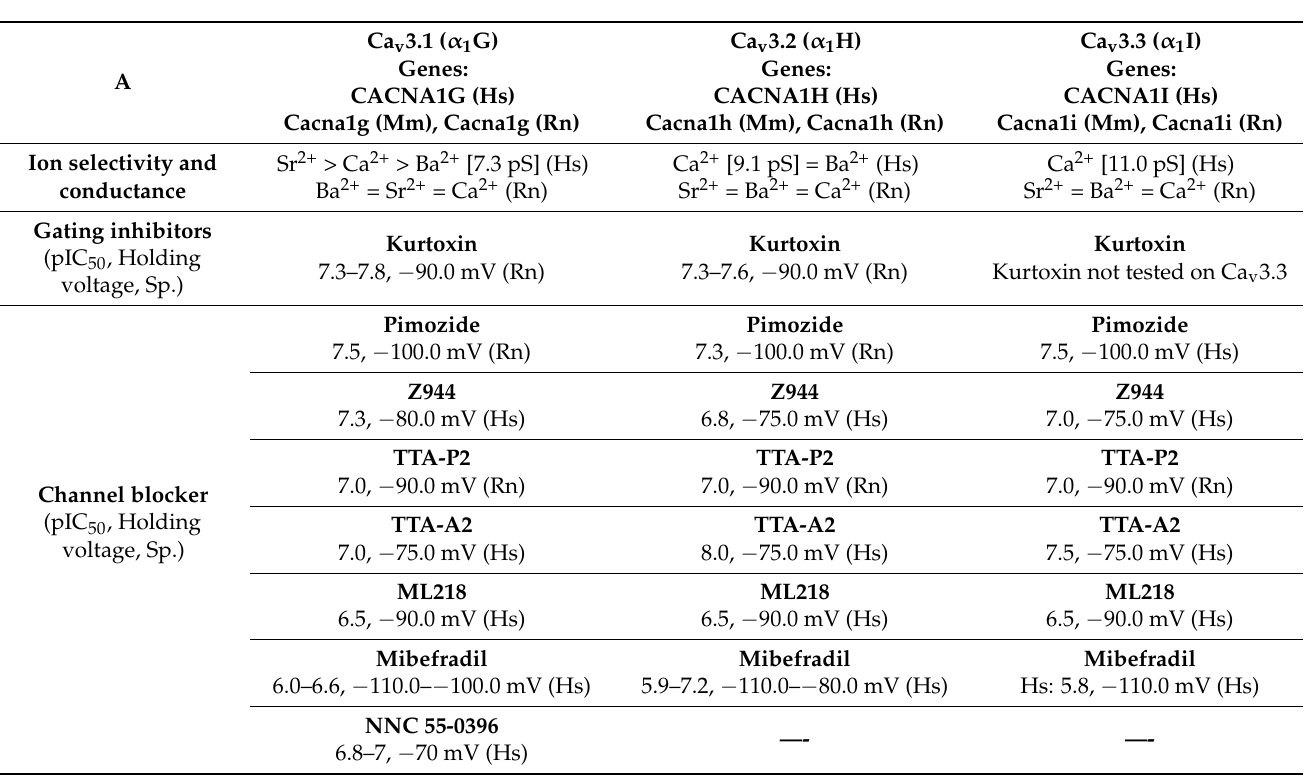
Table 1. Biophysical, electrophysiological, and pharmacological characterization of LVA Ca v 3.1–3.3 T-type VGCCs. Ten different pore-forming Ca v α 1 -subunits have been cloned so far that are dif- ferentiated into three subfamilies, i.e., the HVA, dihydropyridine (DHP)-sensitive, L-type Ca v 1.x channels, the HVA, DHP-insensitive Non-L-type Ca v 2.x channels, and the LVA T-type Ca v 3.x chan- nels. Note that some HVA channels, such as Ca v 1.3 and Ca v 2.3, were also reported to exhibit moderate/mid-voltage activation thresholds and LVA characteristics under specific experimental and (patho)physiological settings. Each pore-forming α 1 -subunit is composed of four homologous domains (repeats I–IV), each of which contains six α -helical transmembrane segments (S1–S6). The pore-forming area is built up by the region between S5 and S6 of the four domains. Voltage-dependent gating of VGCCs is mediated by the voltage sensor, which is localized in the membrane spanning S4 segments and acts via highly conserved positive charges, predominantly arginine residues. Im- portantly, all Ca v α 1 -subunit transcripts are subject to alternative splicing, which can significantly affect biochemical and electrophysiological properties. Various Ca v α 1 -subunits coassemble with auxiliary subunits such as β 1–4 , α 2 δ 1–4 , and γ 1–8 subunits. The auxiliary subunits are capable of mod- ifying the biochemical, electrophysiological, and pharmacological properties of the VGCC complex, although this seems to be of less relevance in T-type Ca 2+ channel physiology compared to the other subfamilies (Ca v 1.x, Ca v 2.x). This table summarizes a selection of genetic, biophysical, electrophys- iological, and pharmacological properties of the Ca v 3 subfamily, which is the focus of this review. In section ( A ), data on ion selectivity and conductance, gating inhibitors, and further Ca v 3.x Ca 2+ channel blockers are listed, including the negative decimal logarithm of the inhibitory concentration (50%) (pIC 50 ) and the related holding potential(s) (mV). For details on the individual parameters, see: [68,95,104–122]. ( B ) Voltage dependence of activation and inactivation kinetics of Ca v 3.x VGCCs in different species. For details on the individual parameters, see: [71,113,117,118,123–128]. Abbrevia- tions: DRG, dorsal root ganglion; Homo sapiens ; Mm, Mus musculus ; RN, Rattus norvegicus ; Sp, species; TCN, thalamocortical neuron; V0.5 act , half-maximum activation voltage; V0.5 inact , half-maximum inactivation voltage; 3 β -OH, neurosteroid analog (3 β ,5 β ,17 β )-3-hydroxyandrostane-17-carbonitrile. *, Electrophysiological data from Ca v 3.x transfected HEK293 cells were obtained from different stud- ies (see